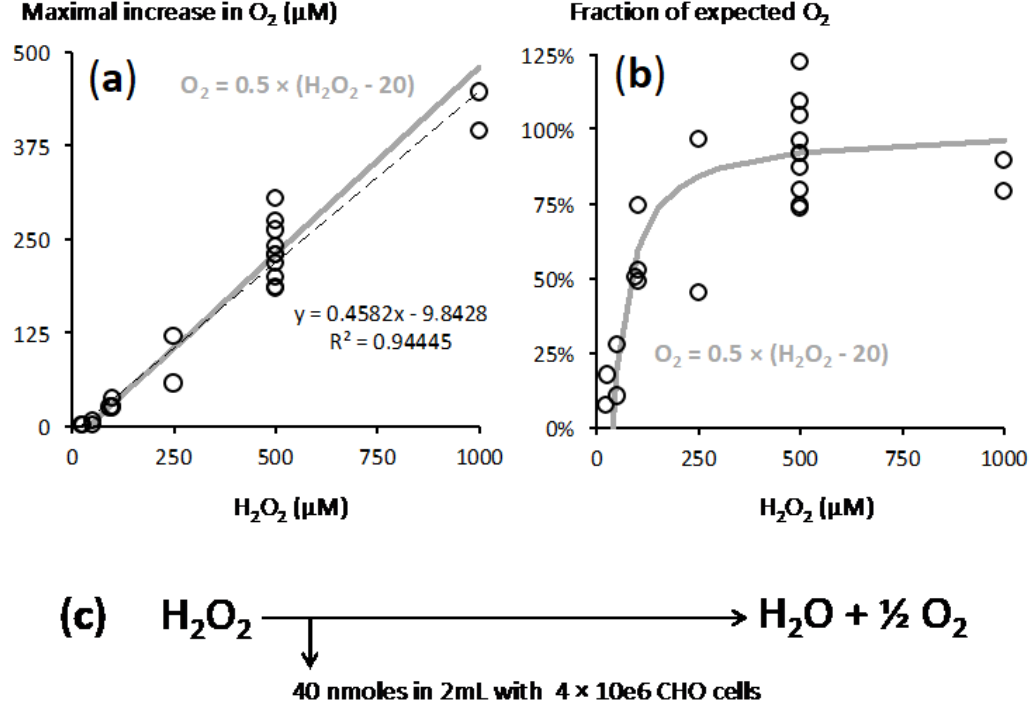
Figure 3. Recapitulation of experimental data led to a model for the reaction between H 2 O 2 and CHO cells. CHO cells suspension ranged from 1.5 to 2.2 × 10 6 / mL. ( a ) X axis = final H 2 O 2 concentration in the medium, Y axis = maximal observed increase in O 2 (see Figure 2 for an example); dotted black line = linear fitting according to the equation shown in grey (with values in µ M) in the panel upper part; grey lines = released oxygen given by the predicted equation of the model. ( b ) Expression of these O 2 increases as percentage of the value expected from full engagement into catalase reaction, same X axis and symbols as in panel a. ( c ) Resulting model: upon H 2 O 2 addition, 40 nanomoles H 2 O 2 are immediately engaged in reactions not leading to O 2 release; the rest of H 2 O 2 is subjected to catalase